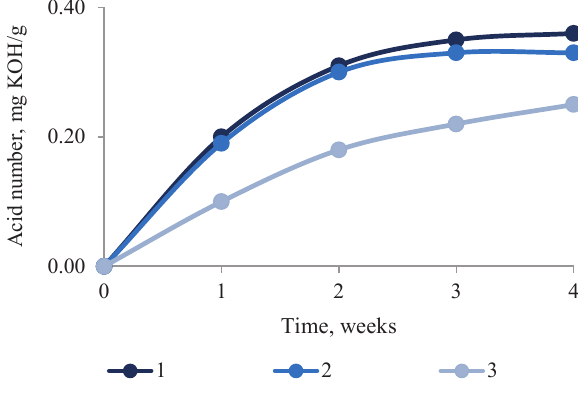
Figure 2 Changes in the acid number of the animal-based food system caused by treatment with Lactobacillus plantarum and Staphylococcus carnosus (1), Staphylococcus carnosus (2) and without starter cultures (3)